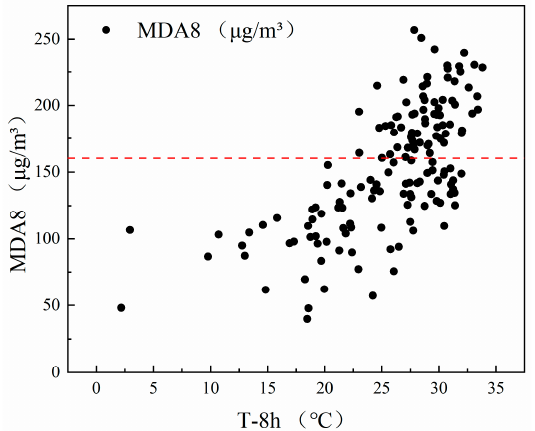
Figure 8. Correlation between MDA8 and T-8h in the same period.